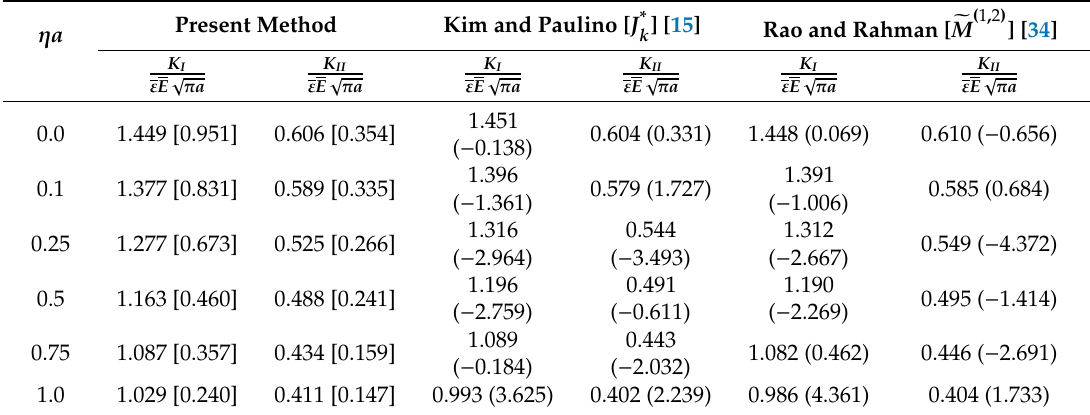
Table 3. Normalized stress intensity factors (SIFs) for an inclined crack in a functionally graded plate. η a Present Method Kim and Paulino [ J * k ] [15] Rao and Rahman [ (cid:101) M